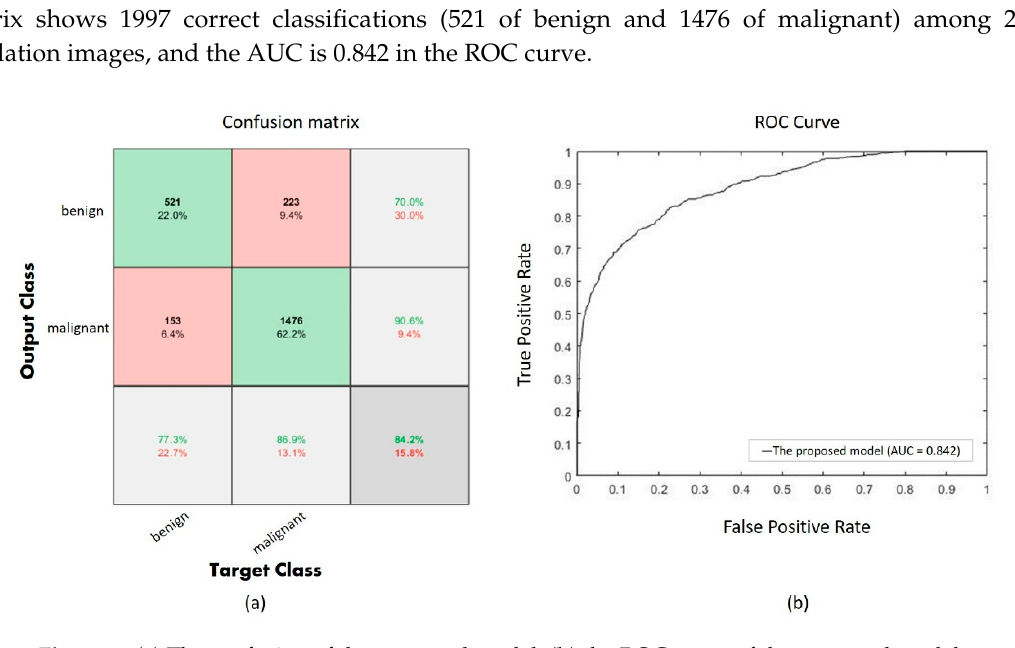
Figure 5. ( a ) The confusion of the proposed model, ( b ) the ROC curve of the proposed model.